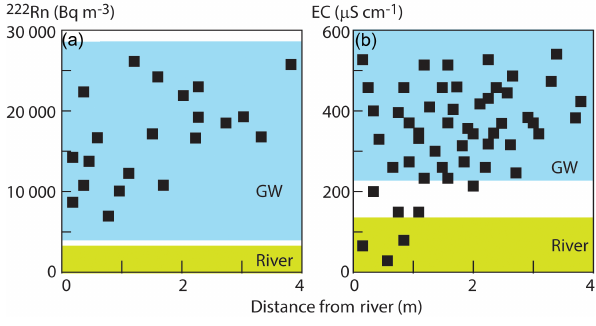
Figure 5. Variations in 222 Rn activities (a) and EC values (b) of water extracted from river bank gravels. Shaded boxes show range of values in the groundwater (excluding Bore 5 at Pieces Lane) and the Avon River (data from Tables A1 and